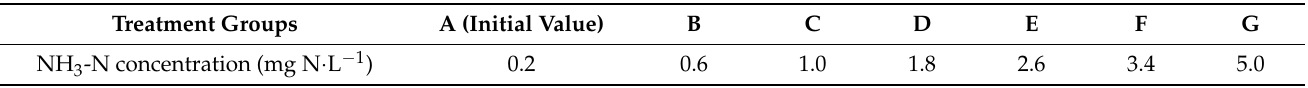
Table 1. Ammonia nitrogen concentrations in the different treatments (mg · L − 1